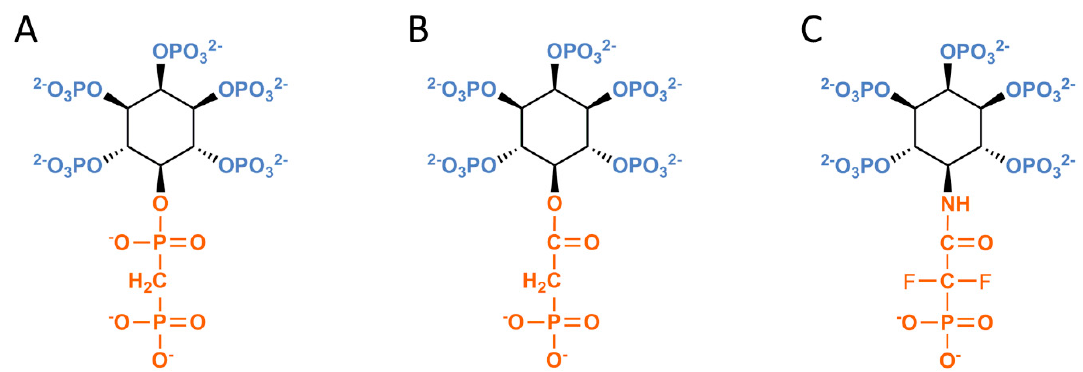
Figure 2. Metabolically stable bioisosteres of 5-InsP 7 . This figure shows synthetic analogs of 5-InsP 7 in which the phosphoanhydride group is replaced with either ( A ) methylene-bisphosphonate (PCP), ( B ) phosphonoacetate (PA), ( C ) phosphonodifluoroacetamide.